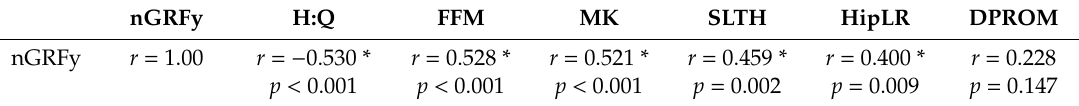
Table 4. Correlation matrix for nGRFy and the independent variables.